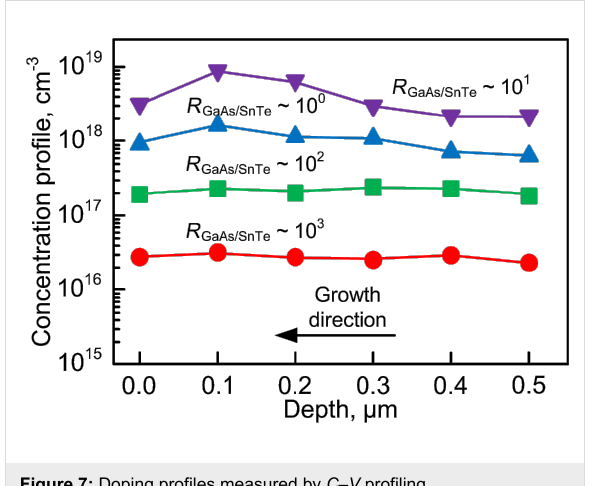
Figure 7: Doping profiles measured by C – V